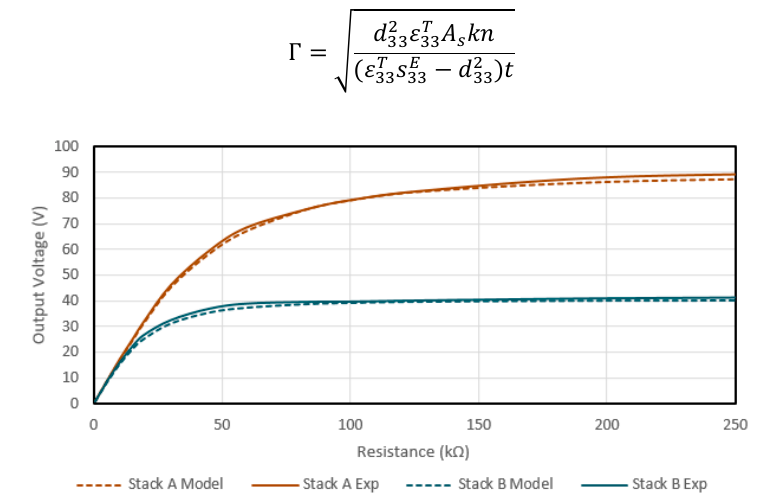
Figure 2. Comparison between modelled (dotted lines) and experimentally obtained (solid lines) output voltage of two different piezoelectric stacks connected to a resistive load, subjected to low frequency directly applied force.